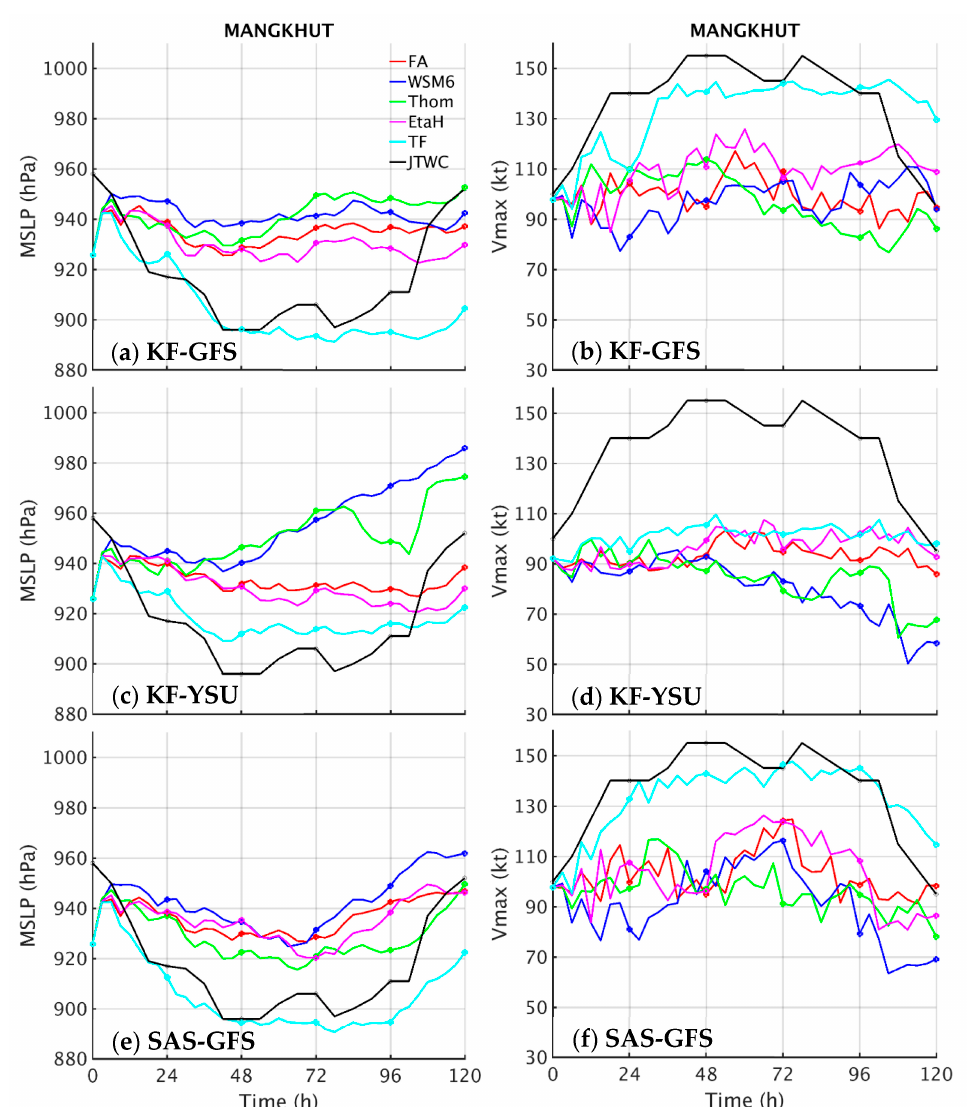
Figure A2. Time evolution of simulated minimum sea-level pressure (hPa) for Mangkhut from 1200 UTC 10 September to 1200 UTC 15 September 2018 for the scheme combination of ( a ) KF–GFS, ( c ) KF–YSU, and ( e ) SAS–GFS. ( b ), ( d ), and ( f ) are the same as in ( a ), ( c ), and ( e ), respectively, but for 10 m maximum wind speed (kt) for a forecast of total 120 h. The red, blue, green, magenta, and cyan lines denote the cloud-microphysics schemes FA, WSM6, Thom, EtaH, and TF, respectively. The best track intensity is from the JTWC (black line).